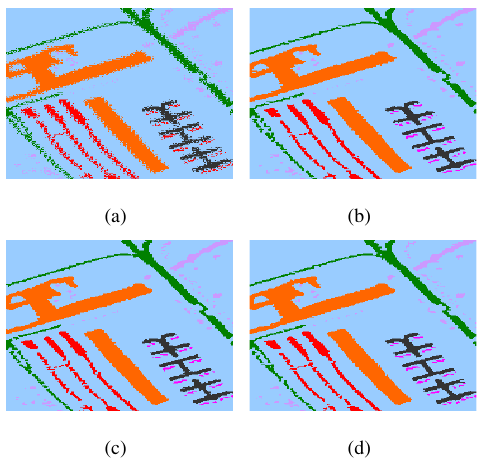
Figure 4. Subpixel mapping results of three algorithms : (a) initialization,(b) BQPSO,(c) CLS BQPSO,(d) SDI BQPSO.